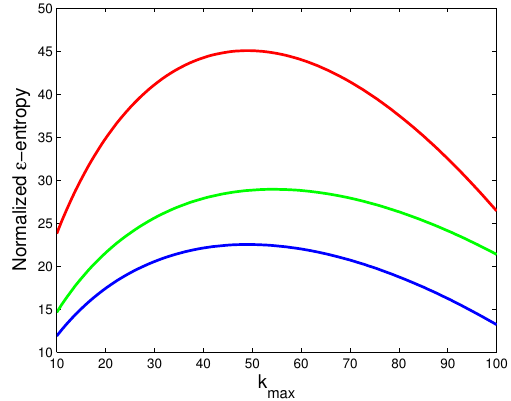
Figure 8: A comparison between the normalized upper bounds of the (cid:15) -entropy associated to the three different configurations, as k max varies in the interval [10 , 100] m − 1 , when M = 2 . The blue line refers to single view /single fre- quency configuration, the red and green line to multi-view and multi-frequency configuration, respectively